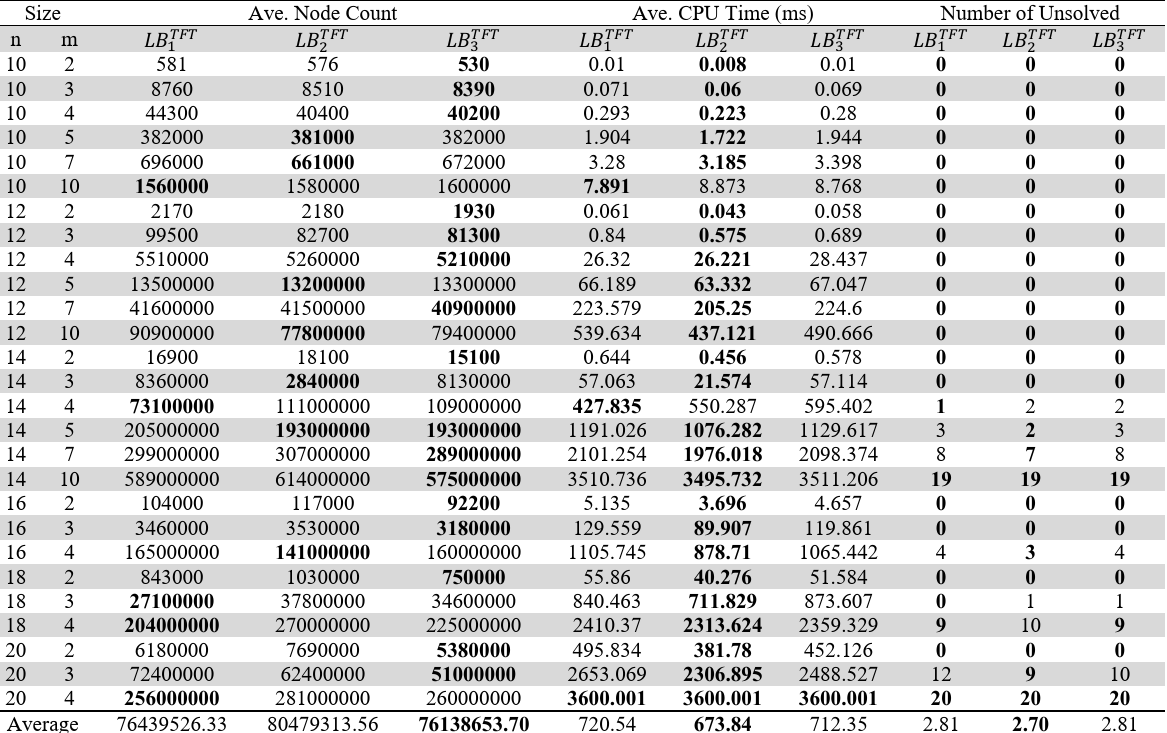
Comparison of the variations of 𝐿𝐵 (cid:3021)(cid:3007)(cid:3021) – Database 1 Size Ave. Node